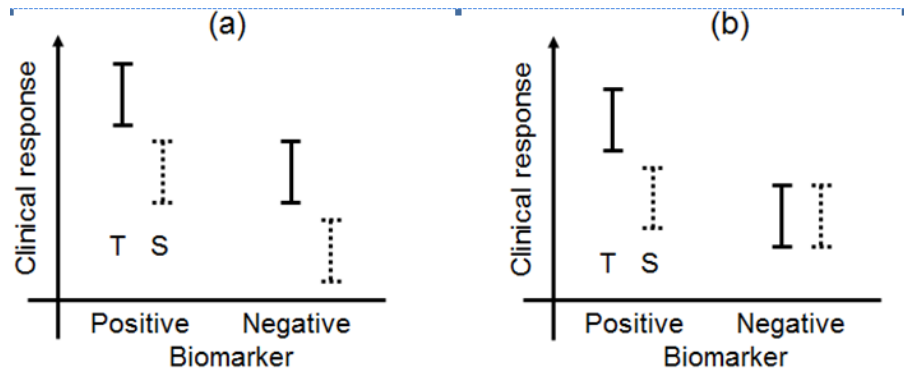
Figure 1. Biomarker types. ( a ) Prognostic biomarker, ( b ) predictive biomarker, ( c ) pharmacodynamic biomarker, ( d ) surrogate endpoint. ‘S’ and ‘T’ denote standard and test treatments,